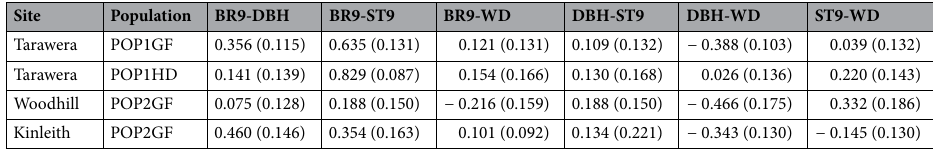
Table 1. Pedigree-based genetic correlation estimates and their standard errors (in parentheses).